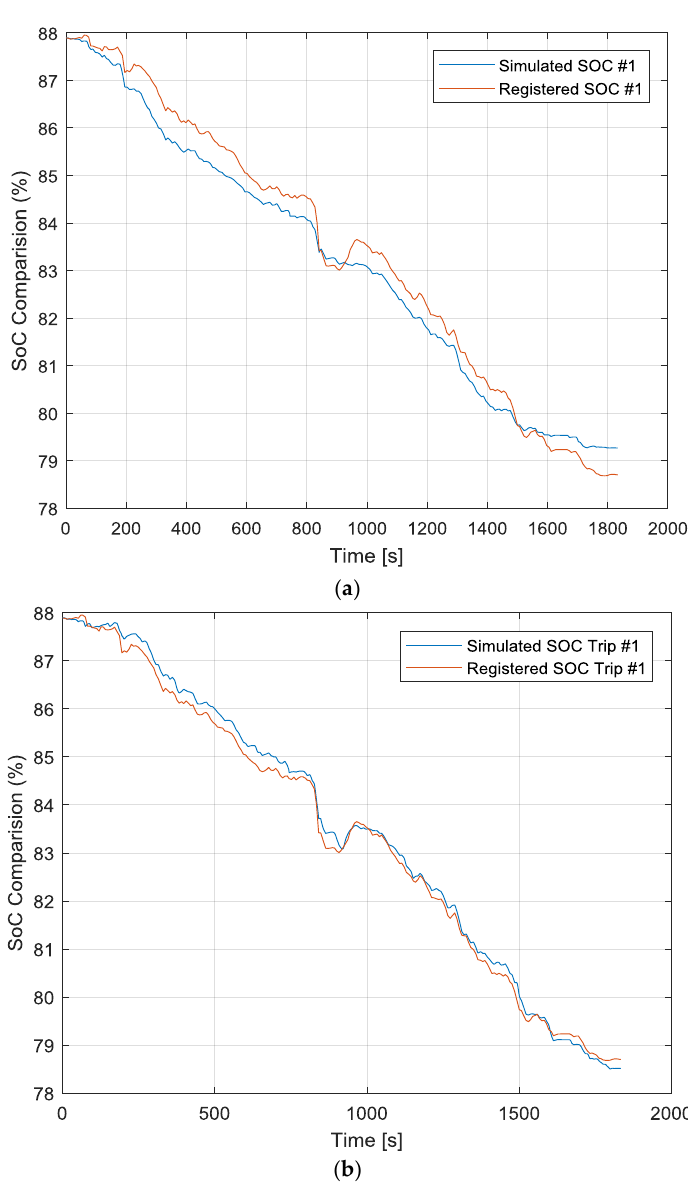
Figure 11. Trip #1 ( a ) Driving events, shown in Figure 9, are not considered in this simulation ( b ) Driving events are considered.